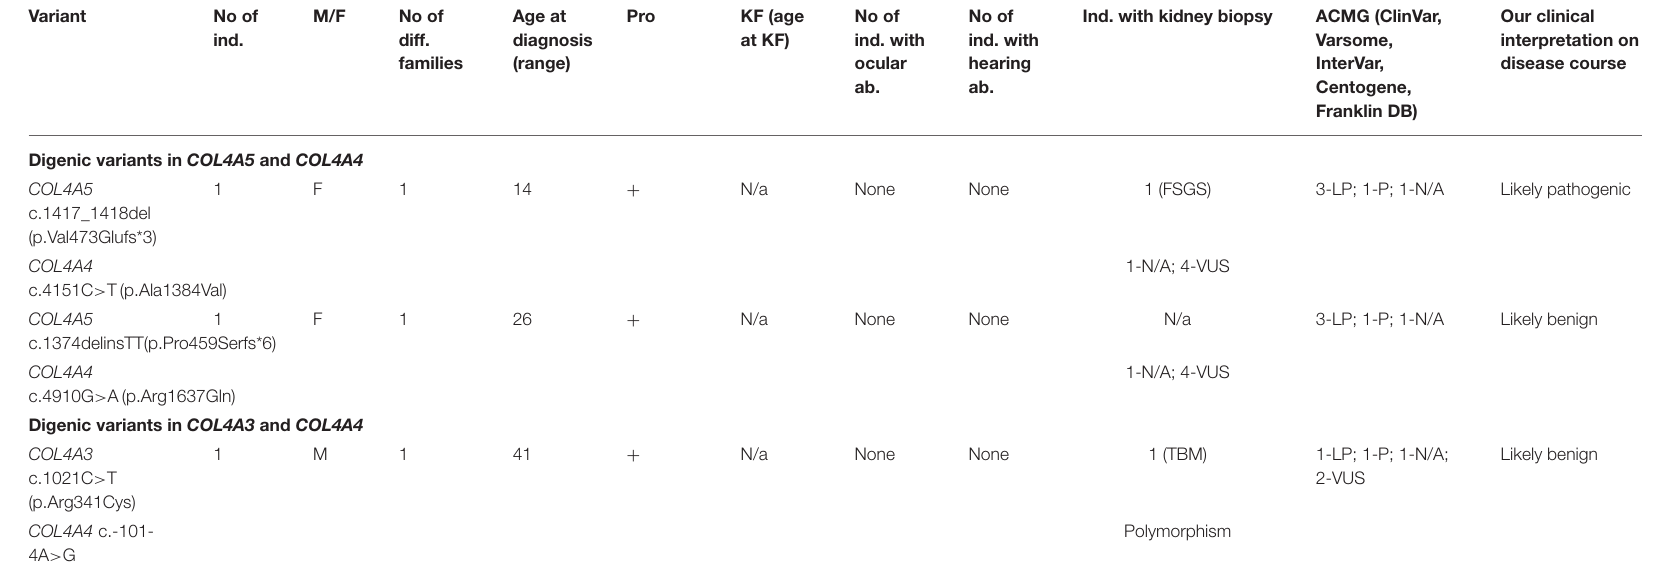
TABLE 7 | Summary of novel digenic variants in COL4A3-A5 (digenic AS). Variant No of